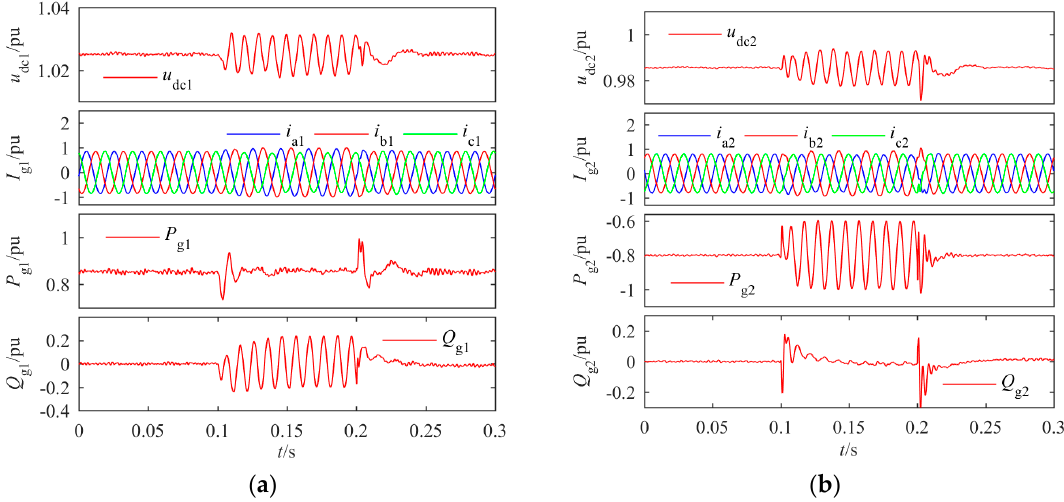
Figure 10. Responses of CS1 ( a ) and CS2 ( b ) to the SOC with proportional-integral plus vector resonant (PIVR) and proportional-integral plus resonant (PIR) controllers respectively.